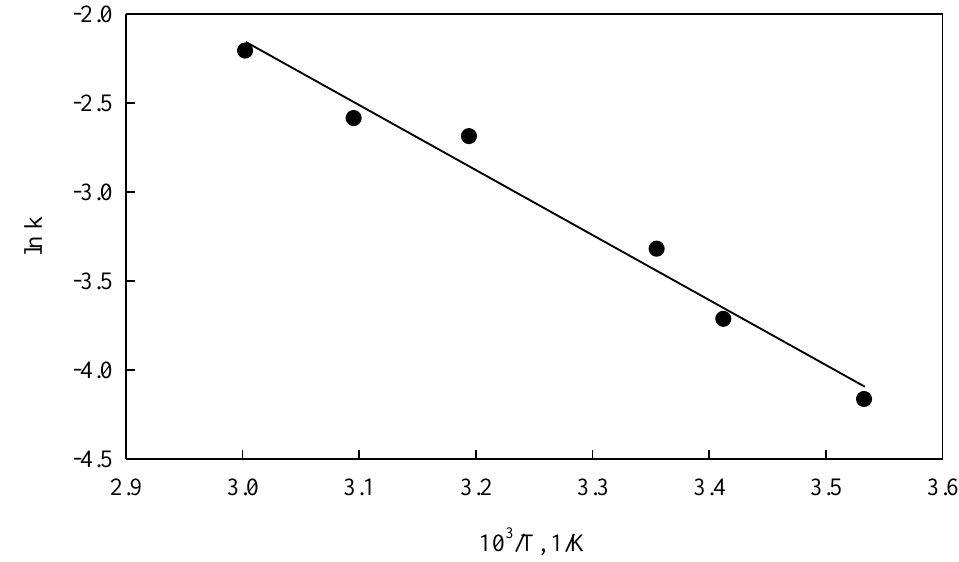
Figure 17. Arrhenius graph for the temperature range 283 to 333 K.